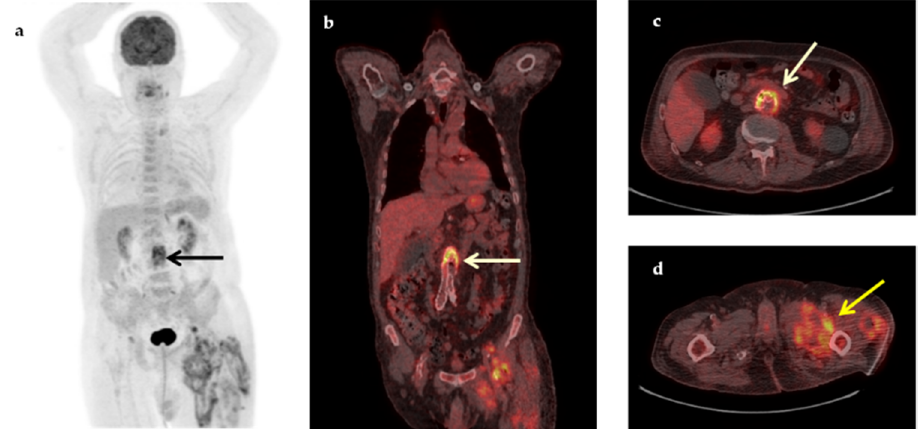
Figure 3. A 74-year-old man with a medical history of aortobiiliac vascular prosthesis because of an asymptomatic aneurysm 5 months ago, presented with a 2-month fever, increased inflammatory blood markers (ESR 83 mm/h, CRP 19.2 mg/dL) and intramuscular fluid collections in the left thigh, (revealed in a CT for localized pain). Maximum intensity projection 18 F-FDG-PET ( a ), coronal fused ( b ) and transaxial fused 18 F-FDG-PET/CT images at the level of the L3 vertebra ( c ), demonstrated increased metabolic activity in the wall of the abdominal aneurysm (arrows) at that level (SUVmax 7.0), suspicious of infection. In addition, transaxial fused FDG-PET/CT image at the level of thighs ( d ) revealed intramuscular hypermetabolic collections with air bubbles in the left thigh, suspicious of abscesses (yellow arrow). Vascular graft infection was confirmed by histopathology after removal of the aortic graft ( Klebsiella pneumoniae, Pseudomonas aeruginosa ).